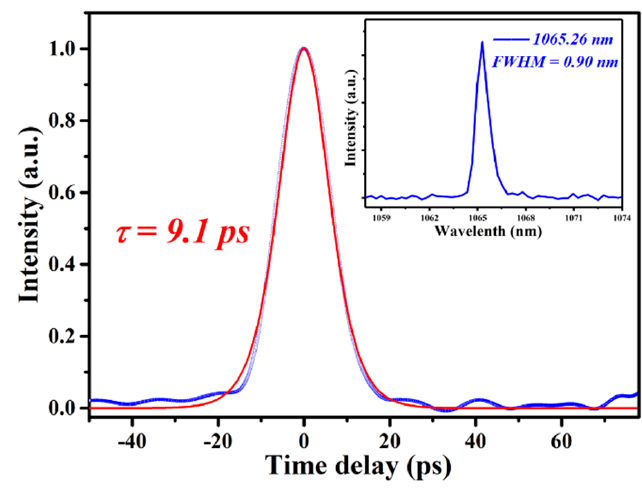
Figure 8. Mode-locking pulse duration and the corresponding spectrum.